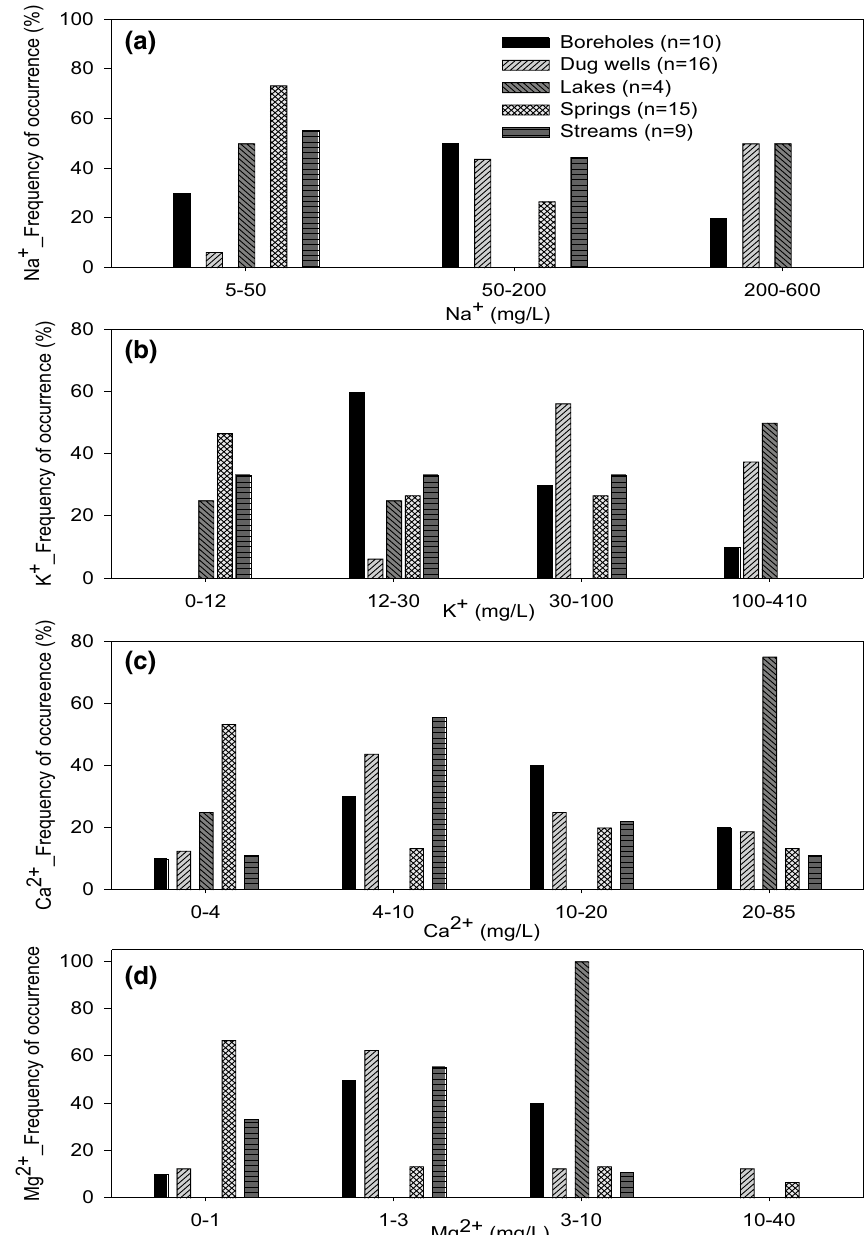
Fig. 7 Major cation